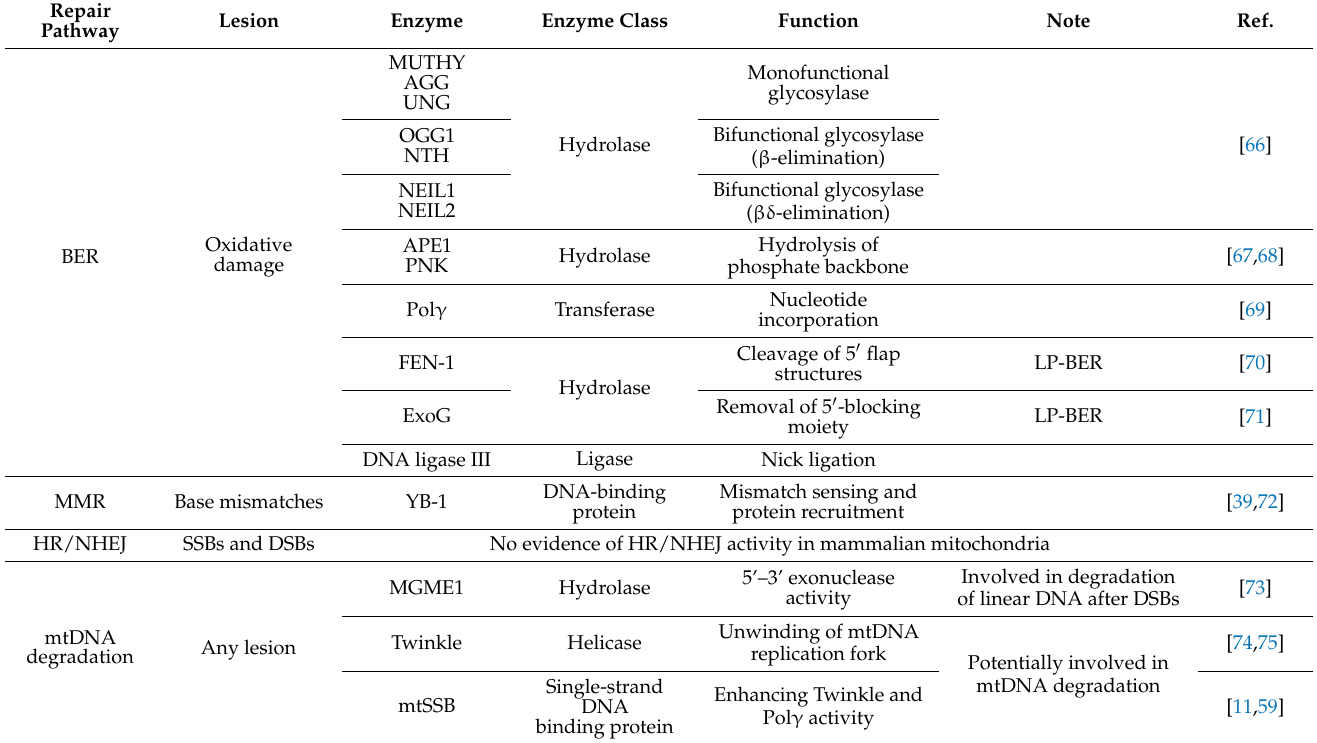
Table 1. Mechanisms involved in mtDNA repair. The best characterised DNA repair pathway in mitochondria is the BER pathway. Several publications have investigated the role of the BER machinery in mtDNA maintenance and the difference to its nuclear counterpart. Attempts to elucidate the presence of other mtDNA repair mechanisms have been performed with contradictory results. Here, we enlist proteins known to be involved in different nuclear repair pathways and that have been studied for their role in mtDNA integrity and stability. Underlined text represents enzymes with exclusive mitochondrial localisation. DSBs = double-strand DNA breaks; HR = homologous recombination; LP-BER = long-patch base excision repair; MMR = mismatch repair; NHEJ = nonhomologous end joining; SSBs = single-strand DNA